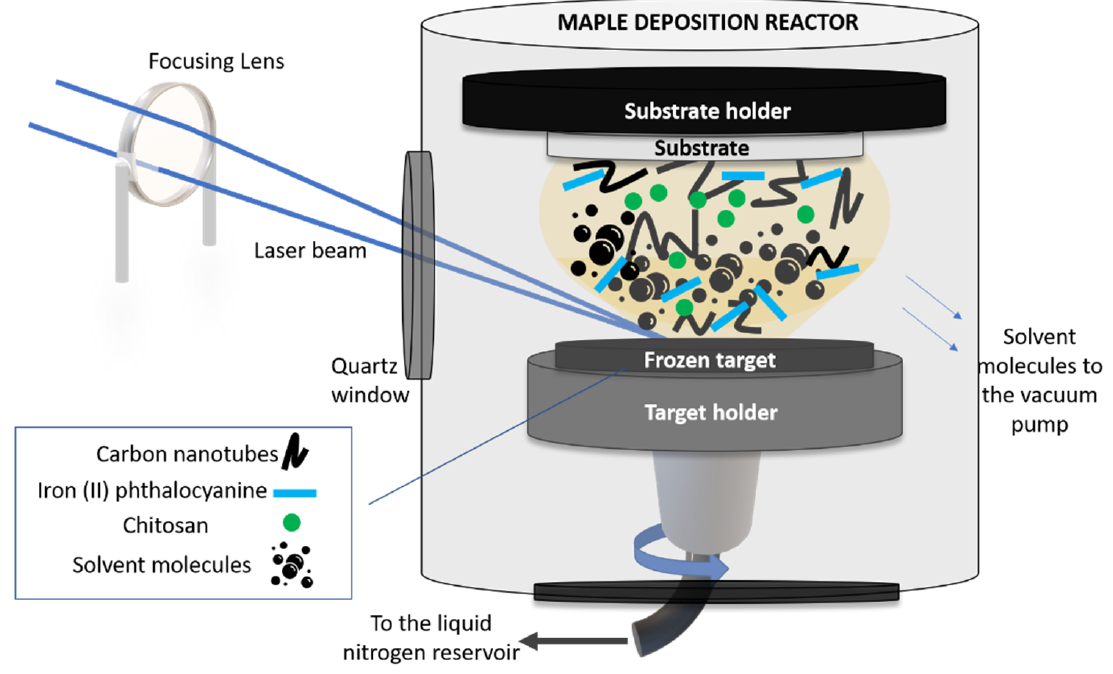
Figure 1. Sketch of the MAPLE setup used in this work.